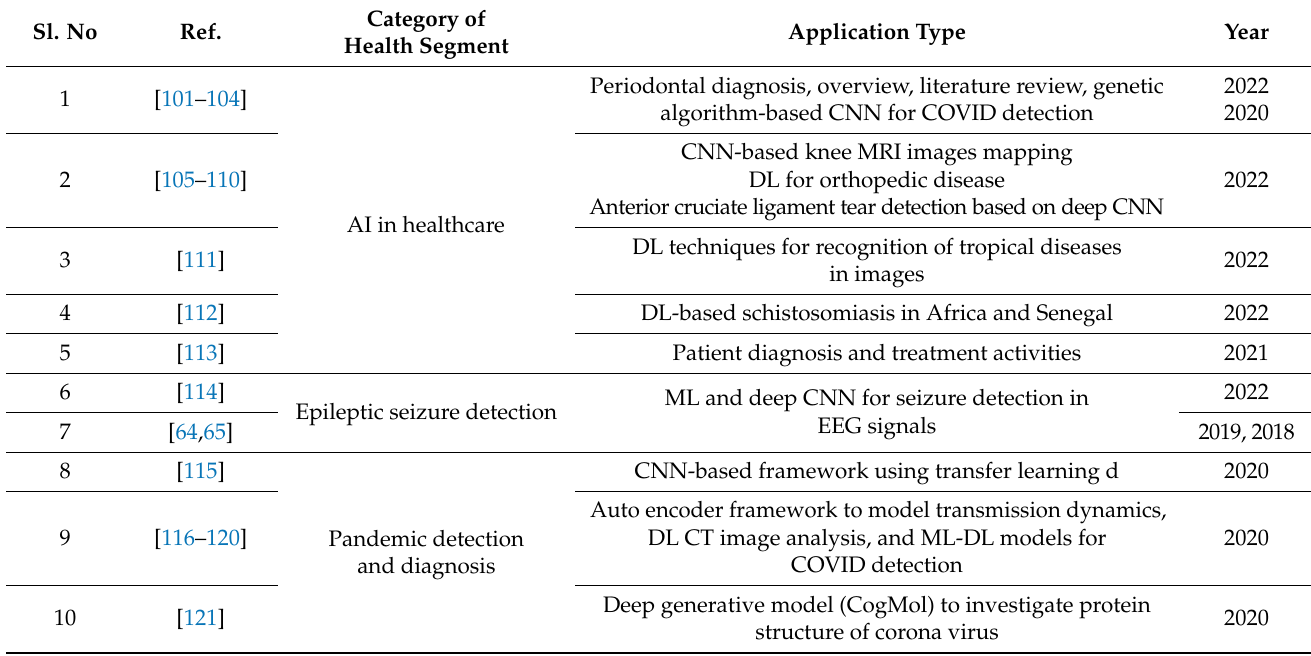
Table 2. Review of AI in Healthcare .